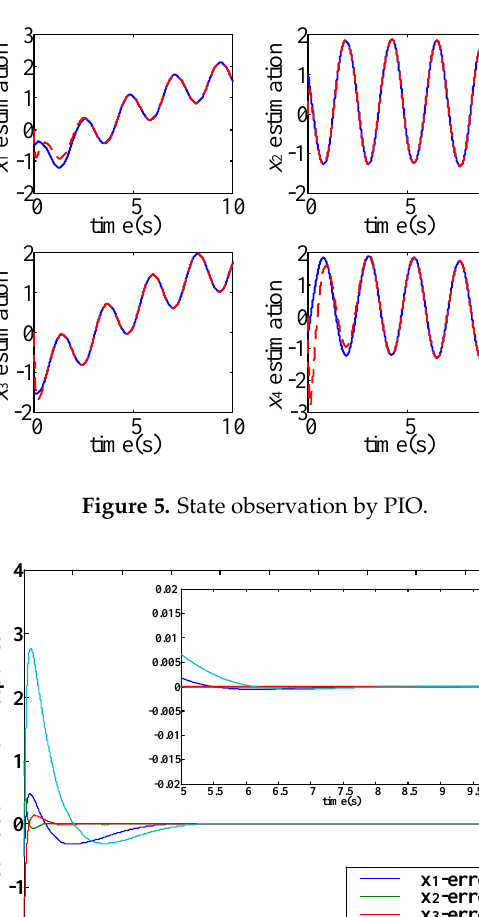
Figure 4. Continuous input recovery by SMO.